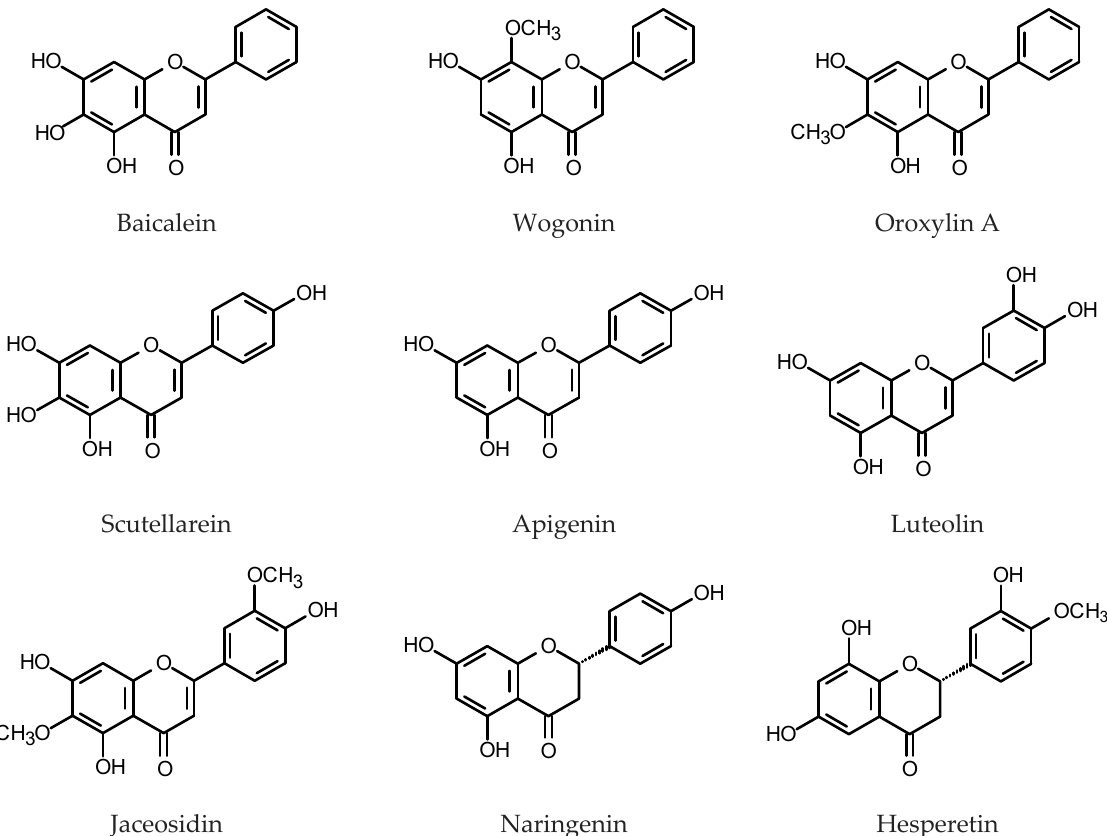
Figure 4. Chemical structures of selected flavones and flavanones.